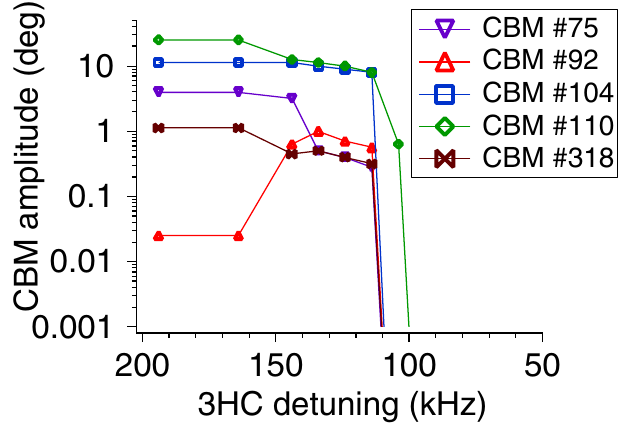
FIG. 4. (Color) CBMs amplitude versus 3HC tuning for a uni- (cid:1) 315 mA , E (cid:1) 2 : 0 GeV form filling of the ring; I beam